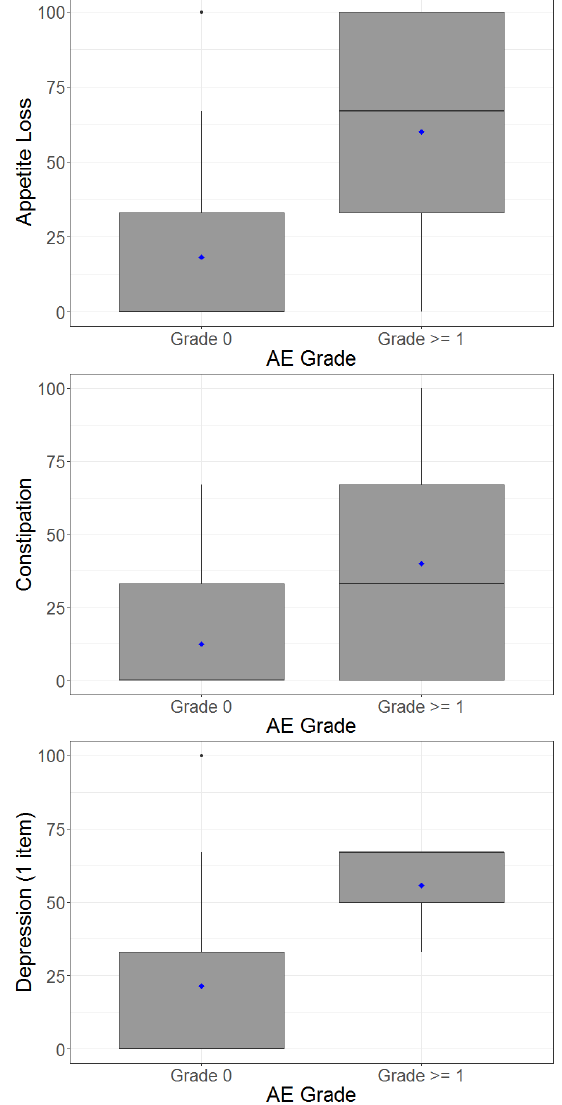
Figure 3. Figure 3. Cont.